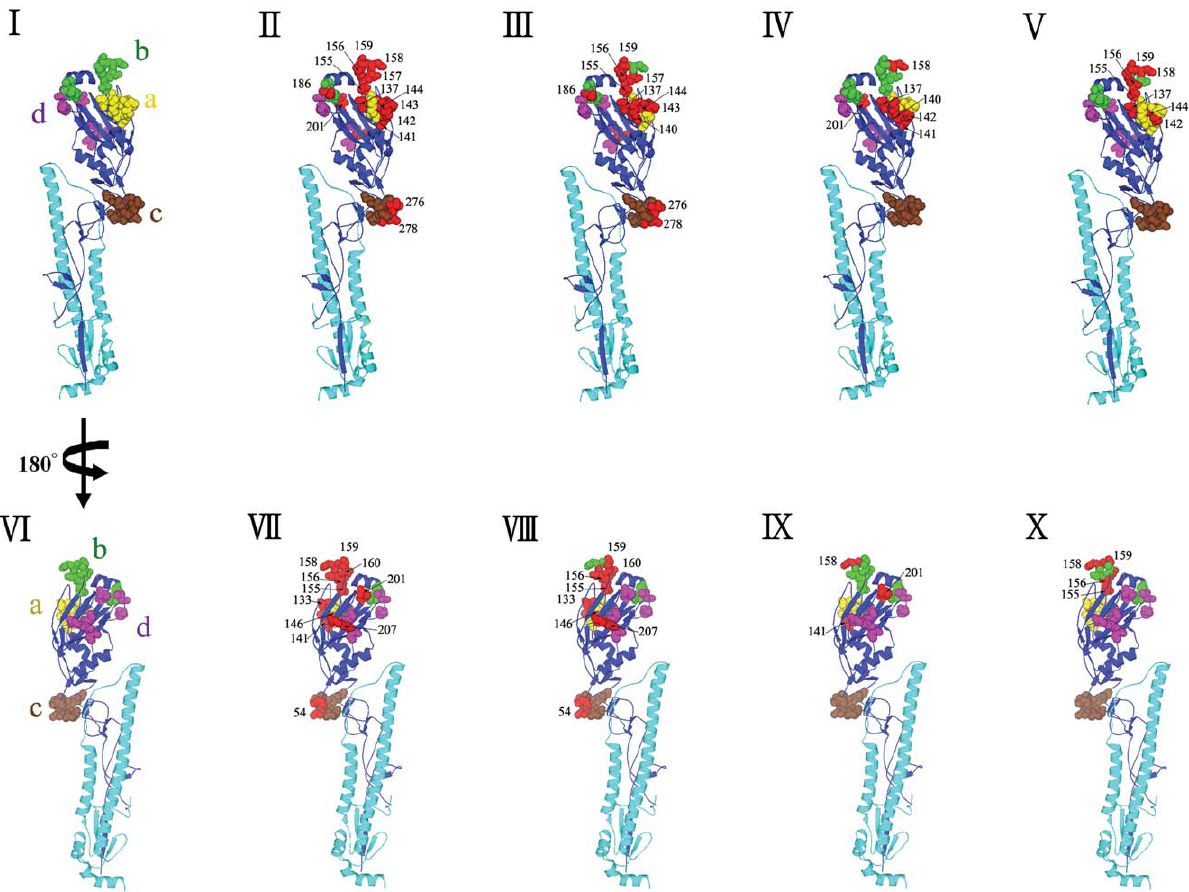
Figure 2. Locations of the amino acid alterations at the major antigenic sites of HA1 molecule in the H3 crystal structure. (I) Side view of a HA monomer in cartoon format with major antigenic sites A, B, C and D shown in spheres (II, III, IV, and V??amino acid changes identified at the major antigenic sites. The locations of changed amino acids are indicated and colored in red. (VI, VII, VIII, IX, and X) Back view of panels I, II, III, IV, and V, respectively. The view in panels I to V is rotated 180 u along Y-axis.TK/ON/FAV-003/2011 vs. DK/MN/1979 (II and VII); TK/ON/FAV-009/2011 vs. DK/ MN/1979 (III and VIII); TK/ON/FAV-003/2011 vs. SW/ON/33853/2005 (IV and IX); TK/ON/FAV-009/2011 vs. SW/ON/33853/2005 (V and X). doi:10.1371/journal.pone.0032858.g002 PLoS ONE |